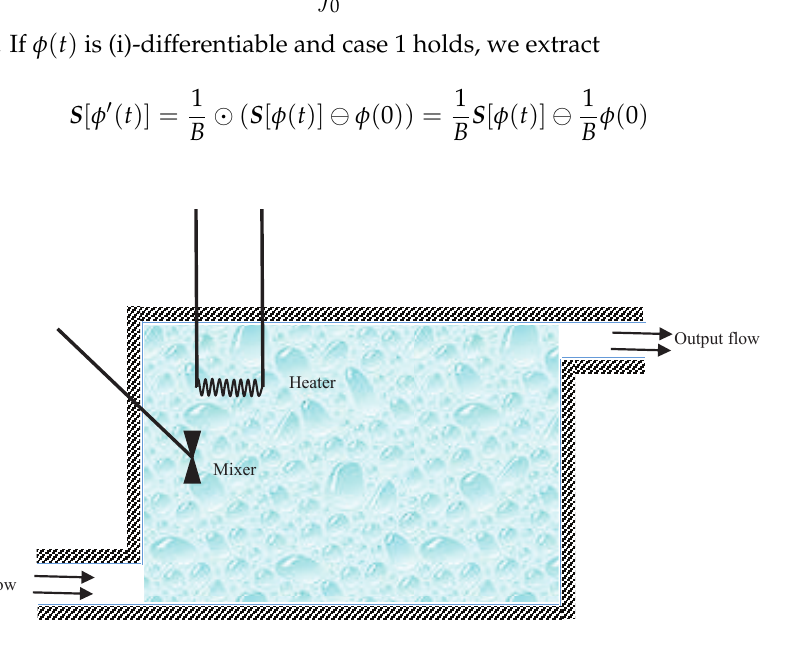
Figure 1. Thermal